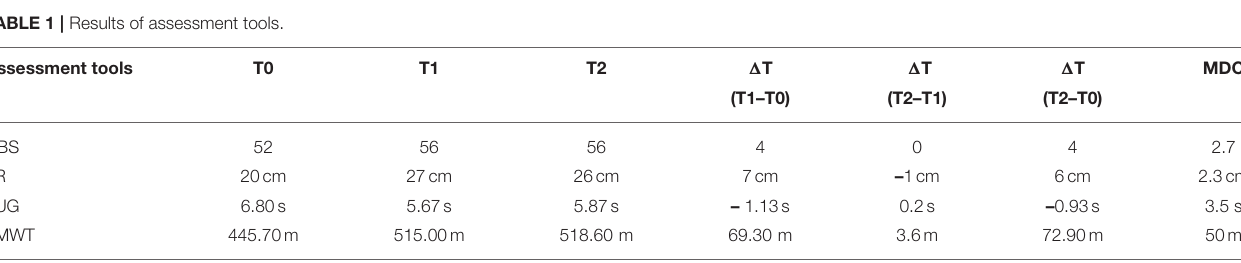
TABLE 1 | Results of assessment